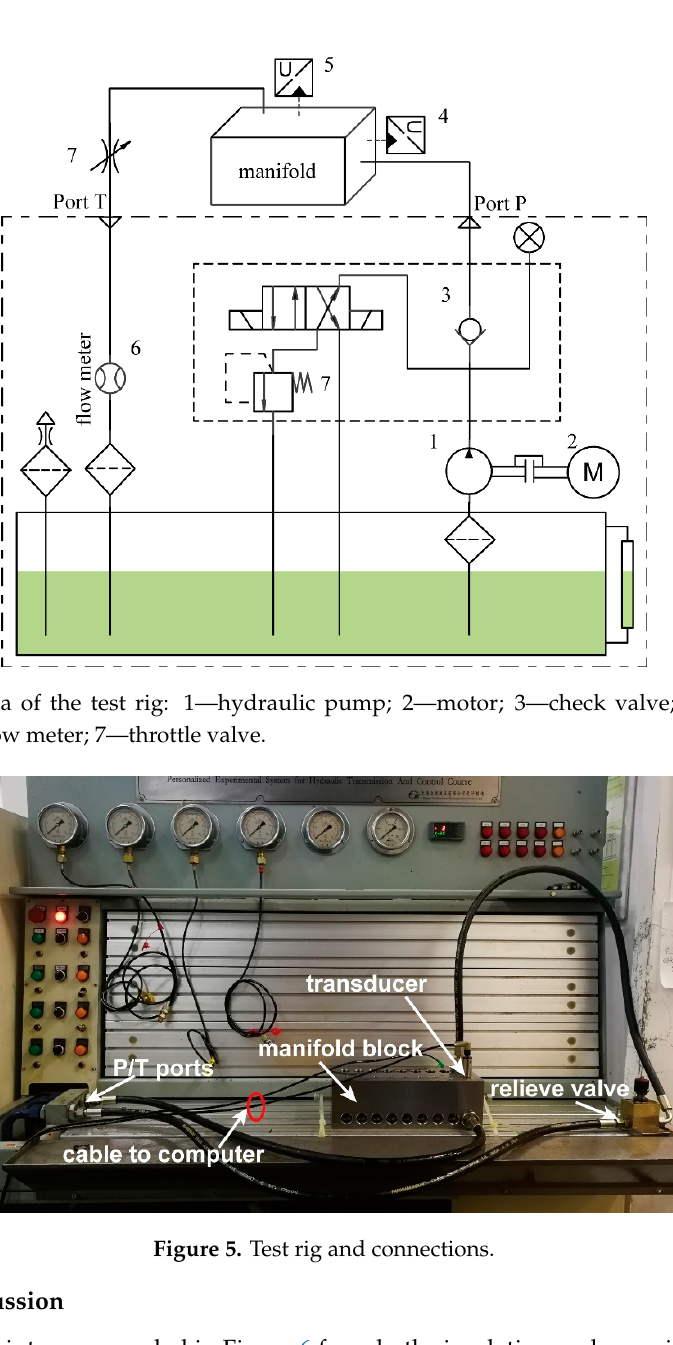
Figure 5. Test rig and connections.